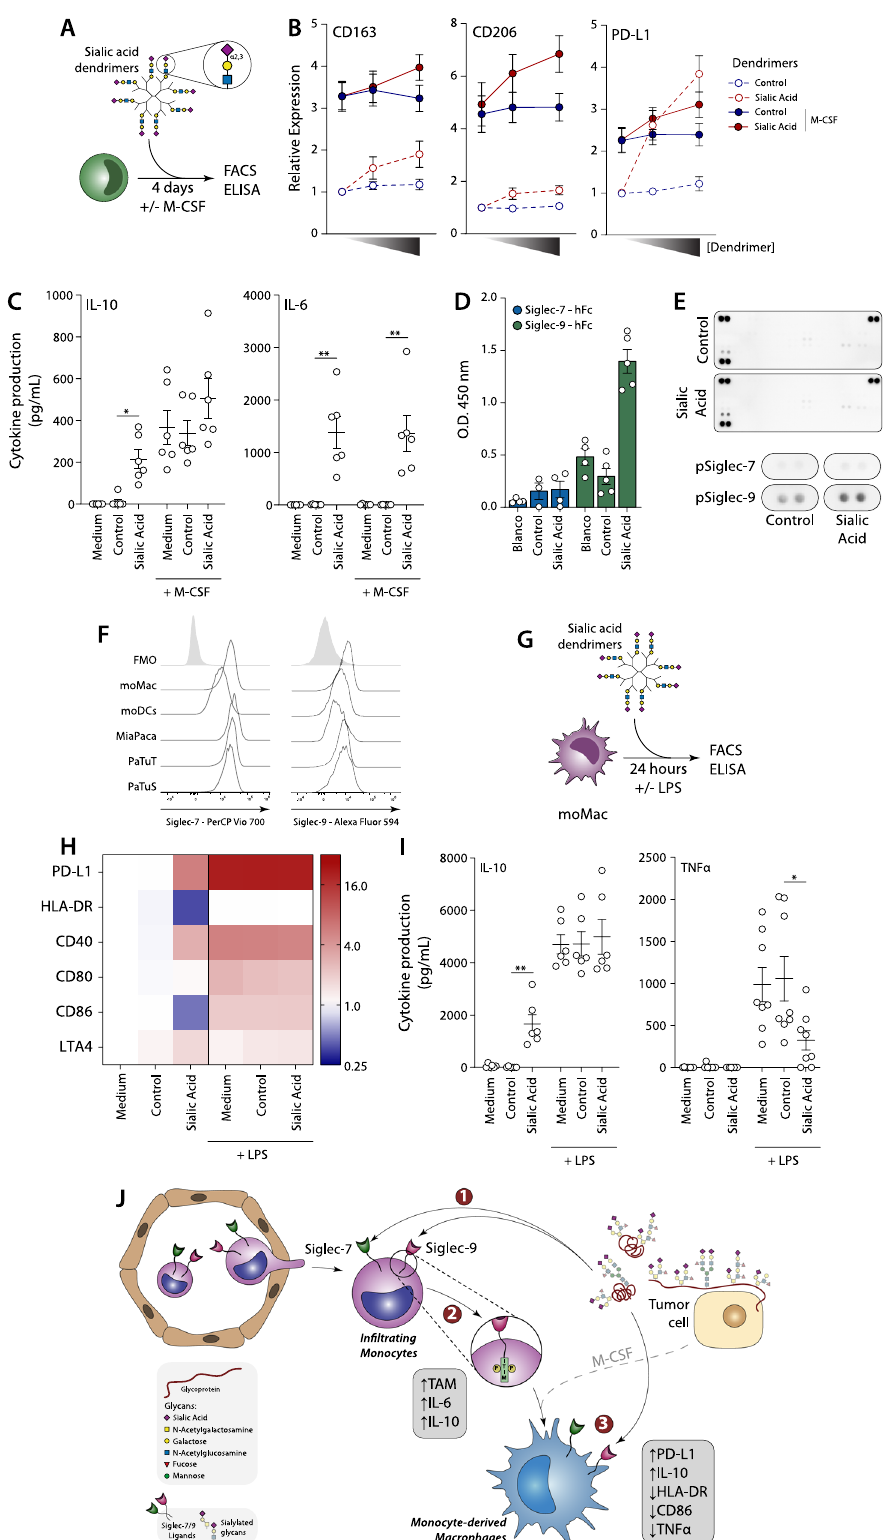
described that the differentiation of moDCs in the TME favours the ef fi ciency of PD-1 blockade 41 . Given that in fi ltrating mono- cytes can contribute to the pool of tumour moMac and moDCs, tunity as complement for immunotherapy. In animal